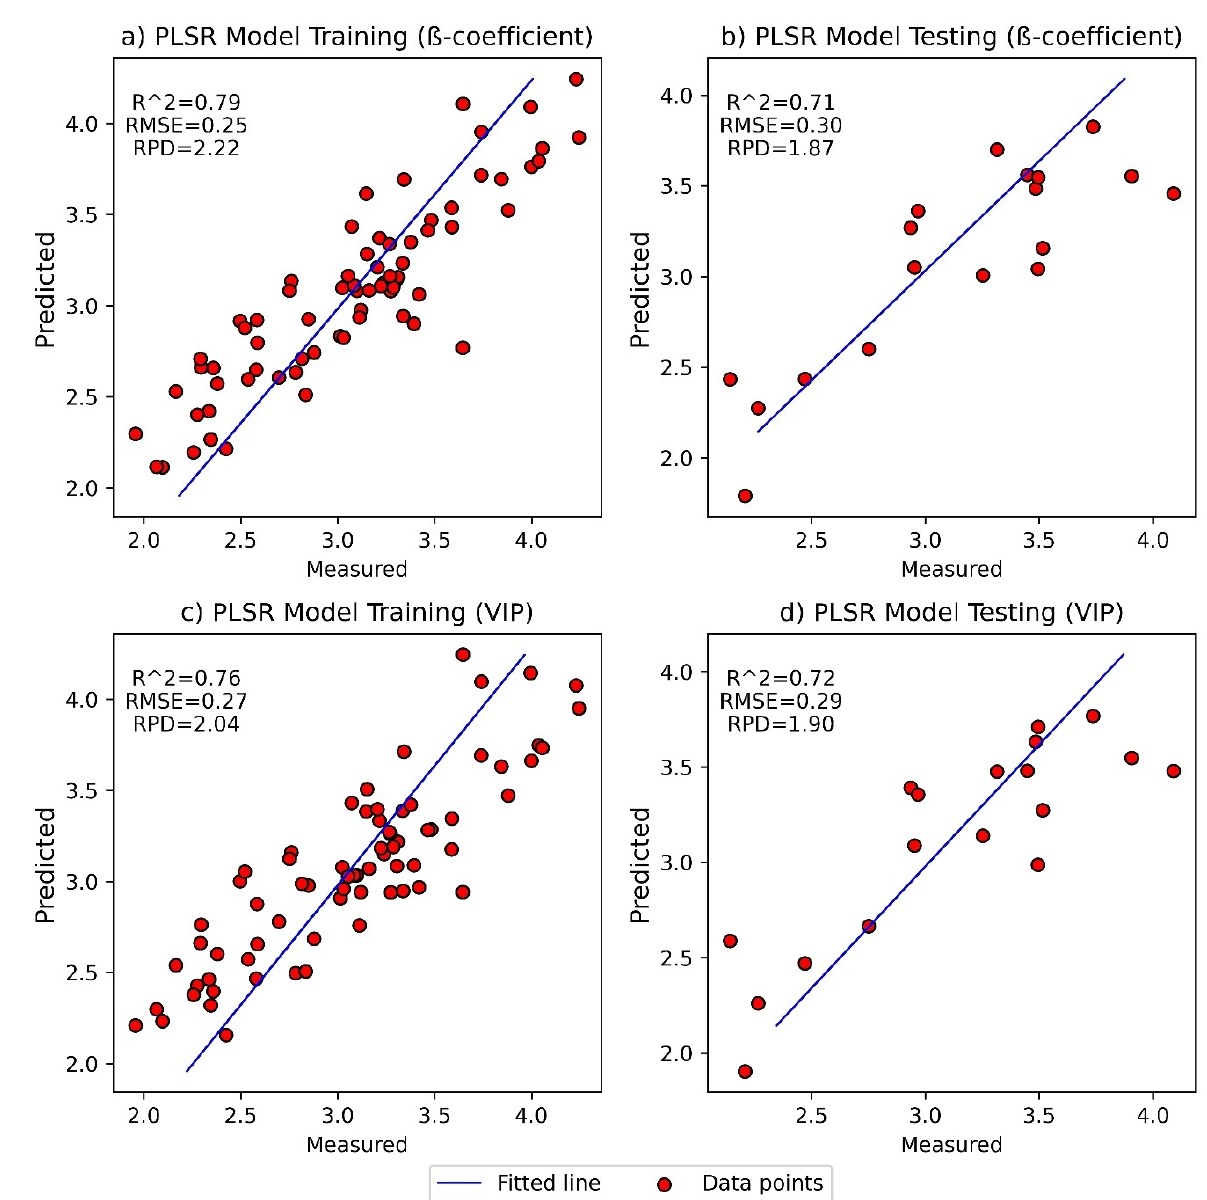
Figure 7. Measured vs. predicted values of the training and test datasets for PLSR model III are presented in Table S2 ( a , b ) and Table S3 ( c , d ) after selecting optimum wavelengths using β -coefficient and VIP score, respectively.